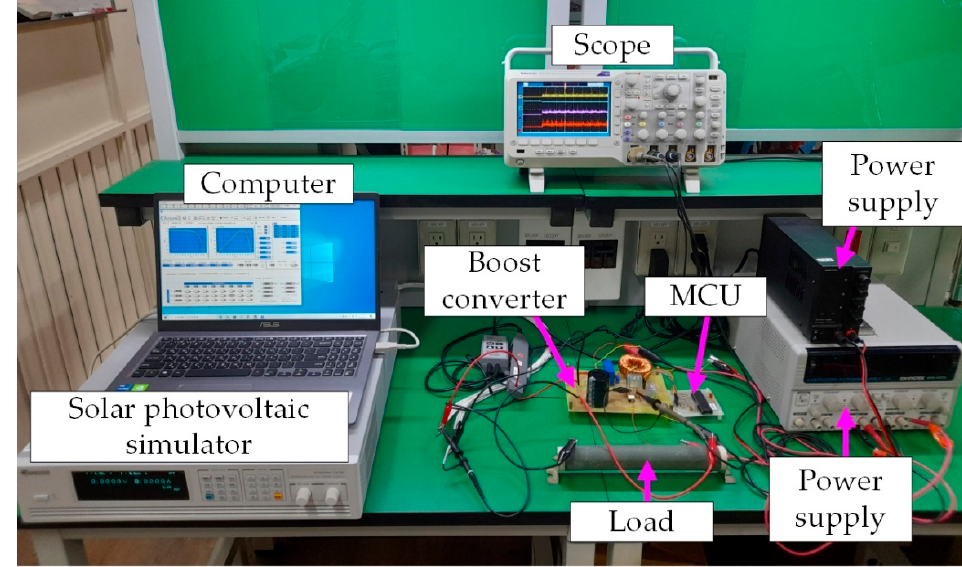
Figure 12. A prototype of the solar photovoltaic system.